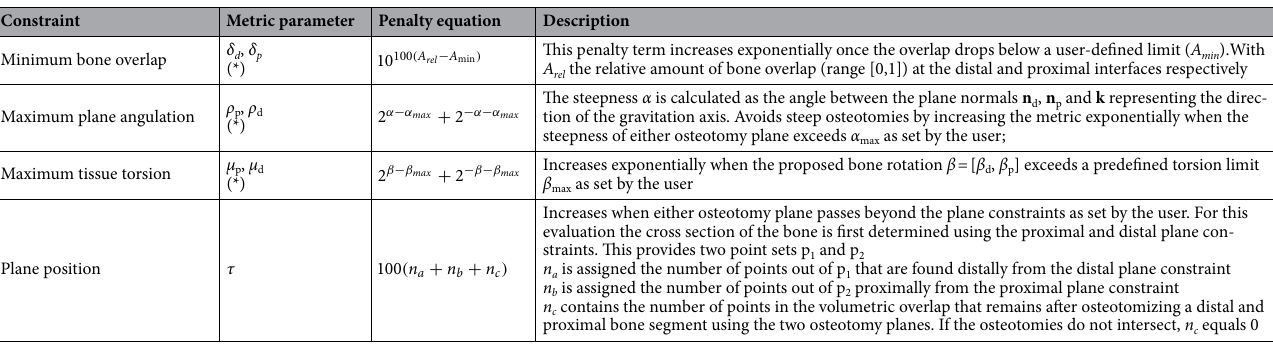
Table 2. Penalty calculation. In cases where the optimizer exceeds a given constraint the penalty largely increases the metric, effectively invalidating the current optimizer attempt. (*) Metric parameter separately determined for distal and proximal plane, as indicated by the index ( d, p